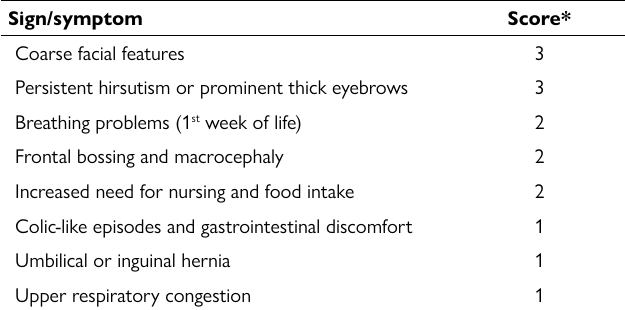
Table 2. Final list of early MPS III signs and symptoms.